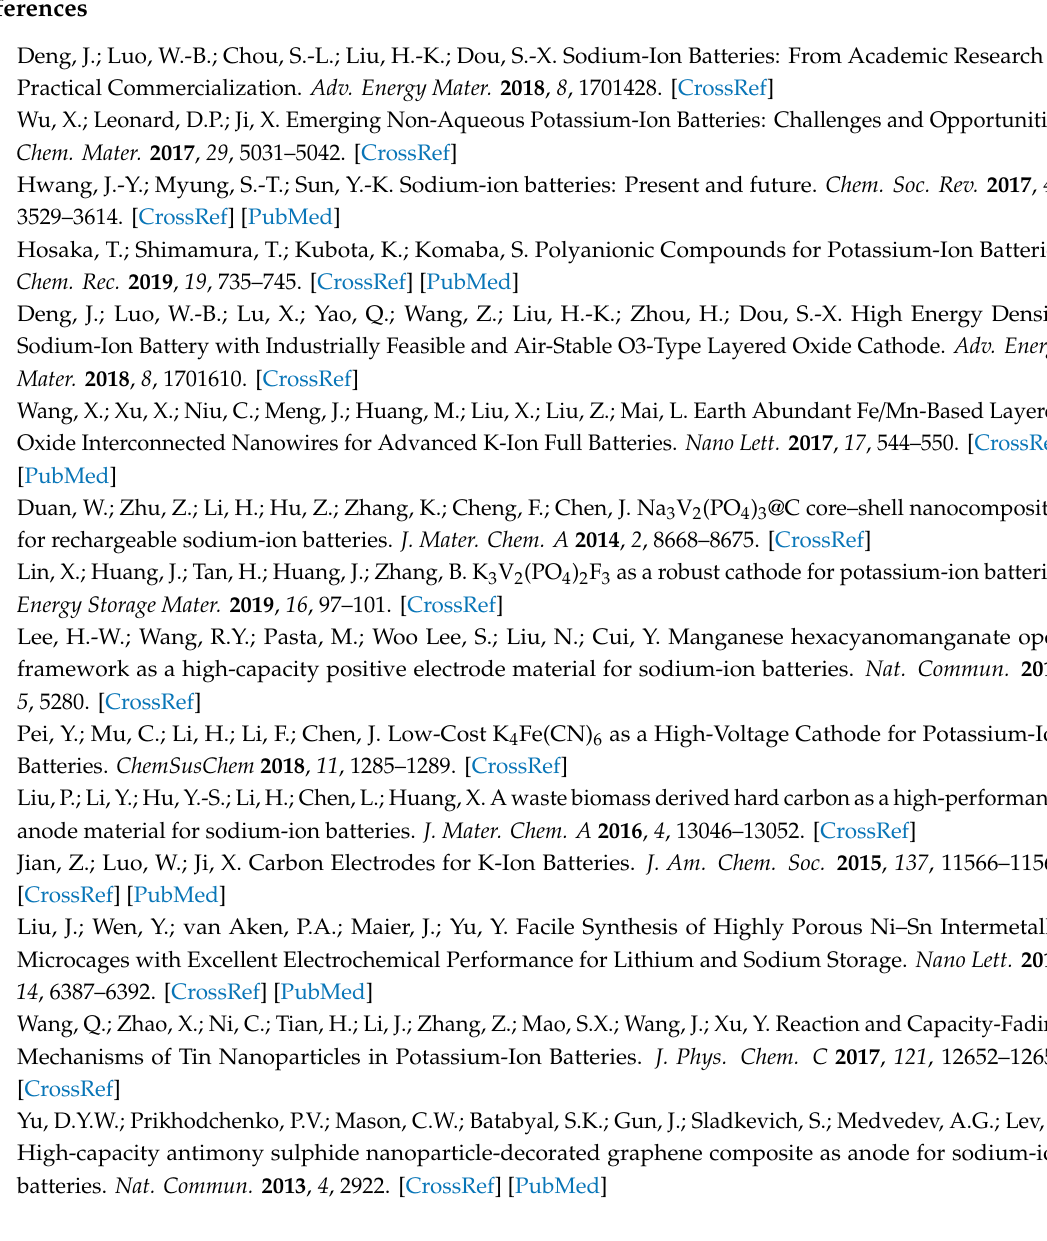
Figure S1: SEM image of pure Sb 2 S 3 , Figure S2: ( a ) TEM and ( b ) HRTEM images of the CNTs, Figure S3: ( a ) Cycle performance of the Sb 2 S 3 anode for NIBs at 100 mA g − 1 . ( b ) Galvanostatic discharge-charge profiles of the Sb 2 S 3 / CNT anode for NIBs measured under various current densities, Figure S4: The galvanostatic discharge / charge curves of the Sb 2 S 3 / CNT anode for KIBs at 500 mA g − 1